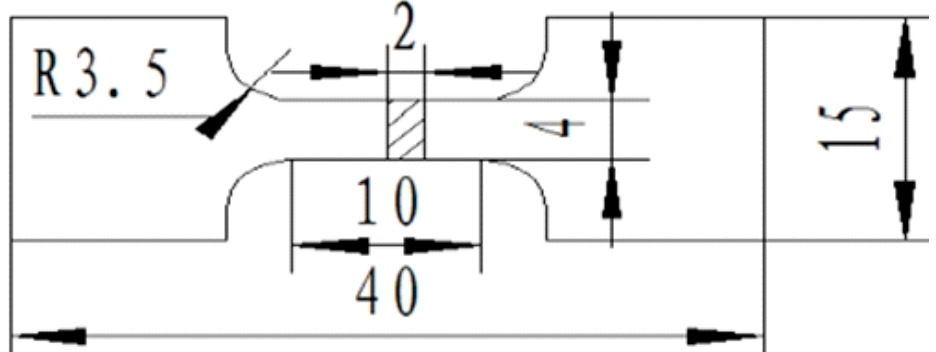
Figure 1. Schematic diagram of tensile sample (mm).